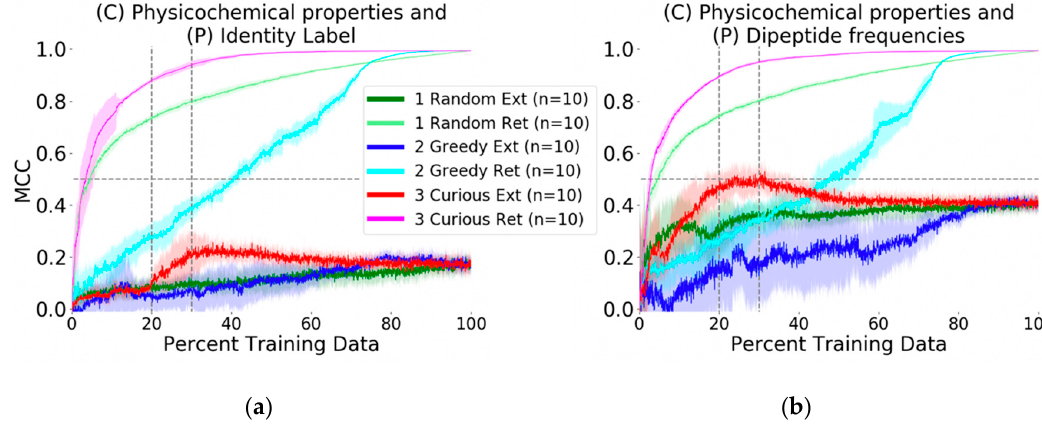
Figure 2. Longitudinal evaluation of active learning. Results are grouped and colored by picking methodology, with light tones for retrospective (“Ret”) evaluation and dark tones for external (“Ext”) dataset evaluation. Curiosity-driven active learning on the MMP non-probe training dataset demonstrates high retrospective predictive ability against the full training set using only 20% of the available training data. However, when targets are described by simple identity vectors (control experiment, panel ( a )), prediction of external probe compound profiles is poor, regardless of ligand-target pair picking strategy. In contrast, describing targets by overlapping primary subsequence frequency yields information that substantially improves the random forest’s ability to discriminate active ligand-target pairs from inactive ones in the external data (panel ( b )).